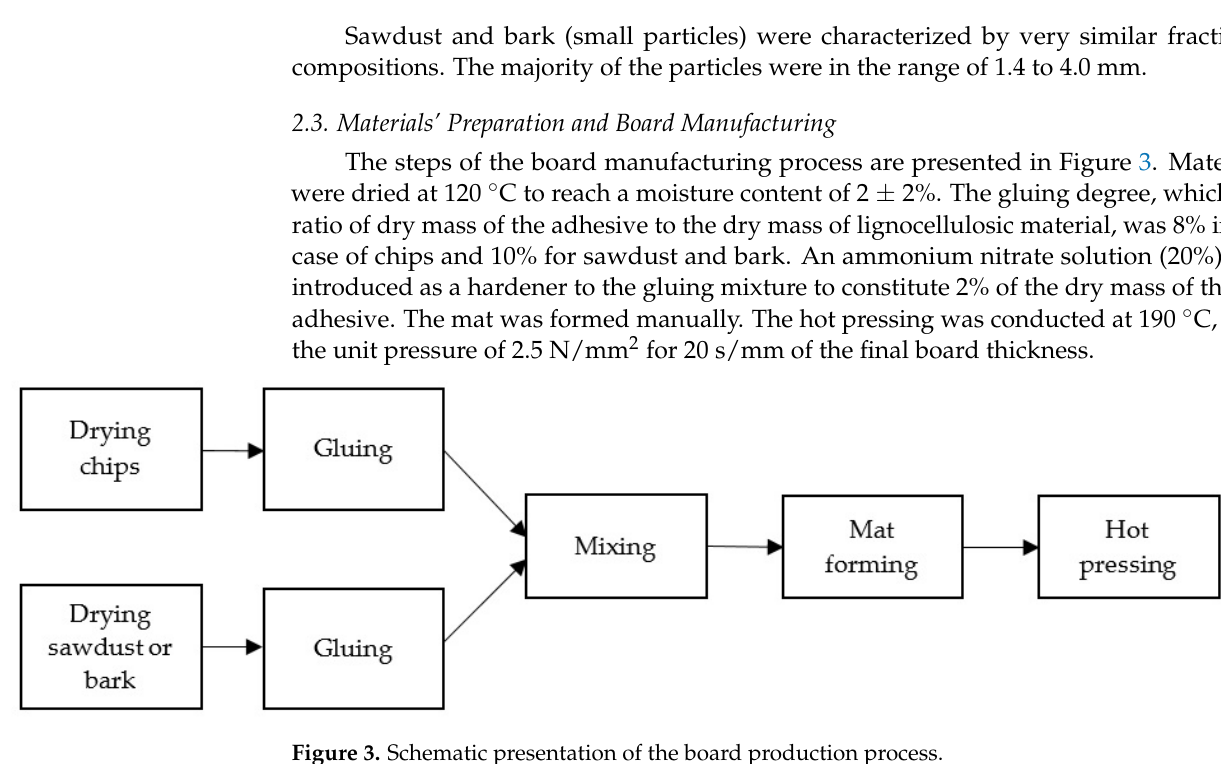
Figure 3. Schematic presentation of the board production process.